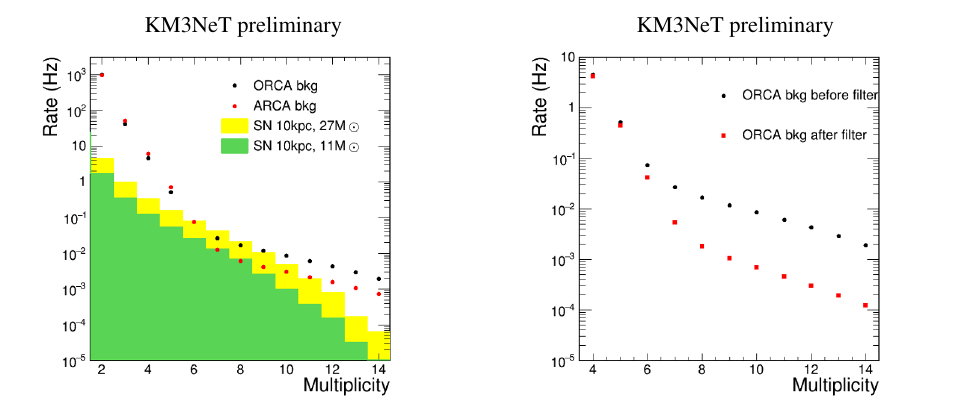
Figure 1. On the left, DOM background rates as a function of the multiplicity for ORCA (black squares) and ARCA (blue squares) from data and expectations for CCSN signal at 10 kpc for the 27 M (cid:12) (yellow filled) and the 11 M (cid:12) (green filled) progenitors. On the right, ORCA rates before (black dots) and after the filter (red